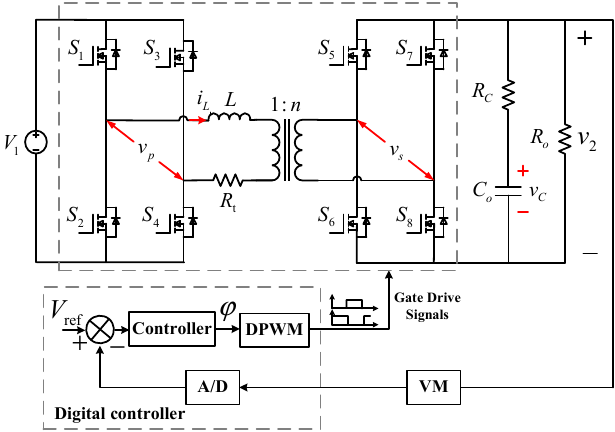
Figure 1. Diagram of the digitally controlled DAB converter.